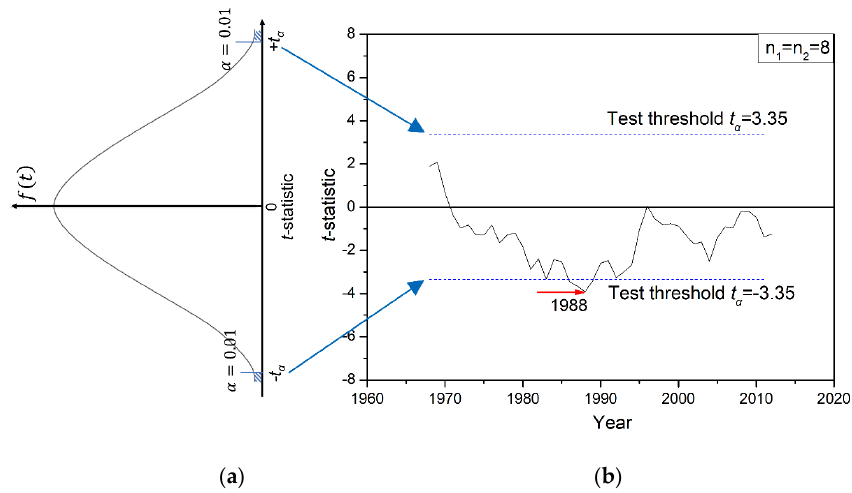
Figure 1. Application case of the Moving t-test method (MTT) method. ( a ) t distribution; ( b ) Mean dry-bulb temperatures tested by MTT method.